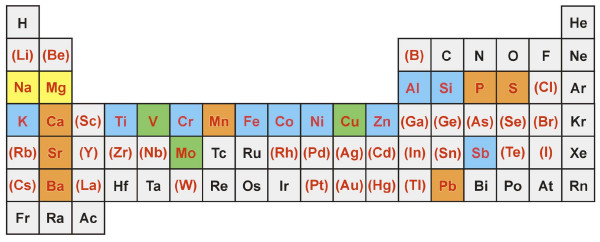
Periodic table outlining chemical analyses of HP12. Those elements shown in red were analyzed using X-ray fluorescence (XRF) and/or inductively-coupled plasma optical emission spectrometry (ICP-OES). Elements in red with parentheses (i.e., (B)) are indicative of elements near or below instrument detection limits. Elements shaded in: 1) yellow represents those that are completely soluble elements (based on deionized water and 1 M HCl extracts using ICP-OES); 2) orange represents completely soluble elements (based on 1 M HCl extract and XRF); 3) green represents those with good agreement between ICP-OES (1 M HNO3 extracts) and XRF; and 4) blue represents those found to be only partially soluble based on ICP-OES extractions.